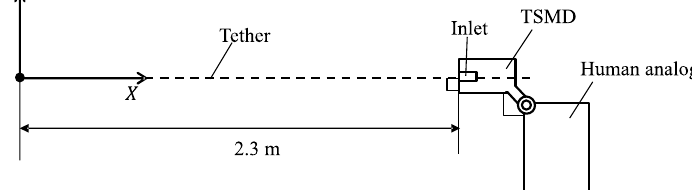
Table 1. Parameters for various simulation conditions.